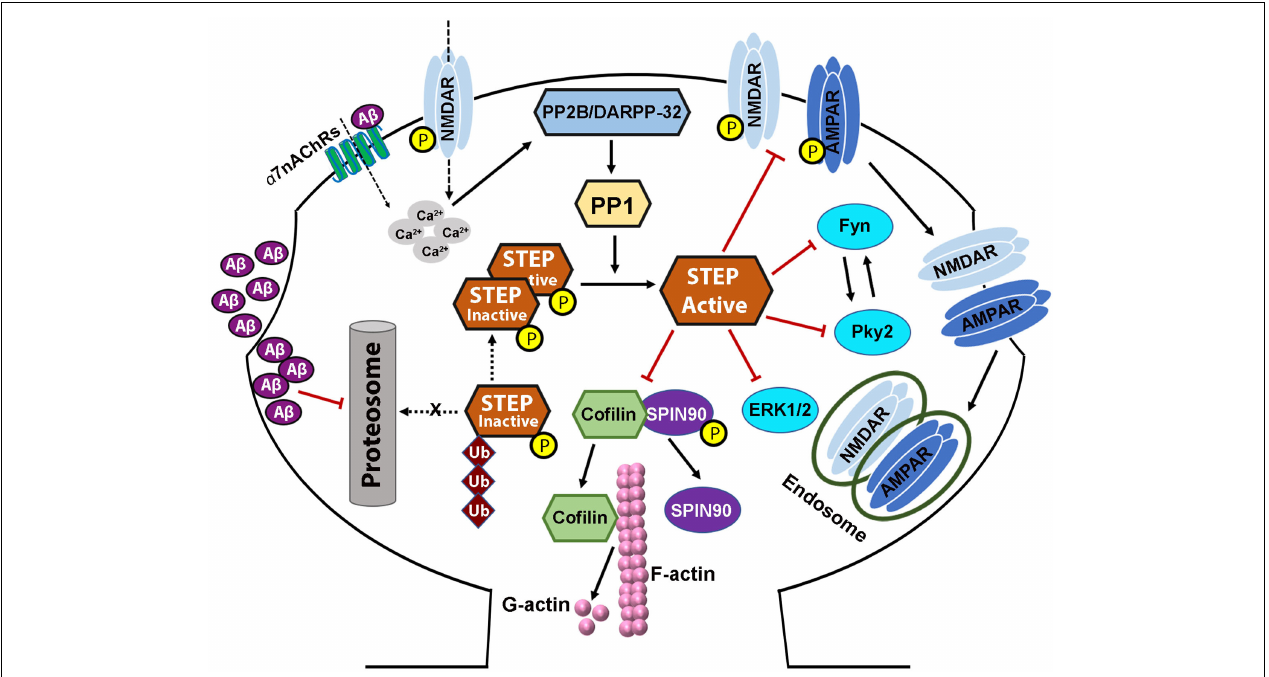
FIGURE 4 | STriatal-enriched protein tyrosine phosphatase dysregulation in Alzheimer’s disease. Both protein level and activity of STEP are implicated in Alzheimer’s disease, and are thought to be the result of increased A β . Increased soluble A β levels precede the appearance of cognitive impairments. A β activation of α 7nAChRs, together with glutamatergic NMDAR stimulation, increased calcium influx which then activates PP2B/DARPP-32/PP1 pathway leading to the dephosphorylation and activation of STEP. On the other hand, A β can also inhibit the proteasomal degradation of STEP leading to accumulation of STEP. These together lead to increased level of active STEP which aberrantly dephosphorylates its substrates. Dephosphorylation of SPIN90 by STEP also leads to the dissociation of SPIN90 from cofilin, leading to the activation of cofilin which then depolymerizes F-actin to G-actin. These events, together with the inactivation of other STEP substrates, and AMPA and NMDA receptors’ internalization, lead to dendritic spine and synapse loss resulting in the learning and memory and cognitive impairments seen in AD. A β -induced alterations in PKA/Akt/CREB pathway result in deficient BDNF/TrkB signaling, which in turn, contributes to the synapses loss and synaptic plasticity and cognitive deficits, via impairing the degradation of